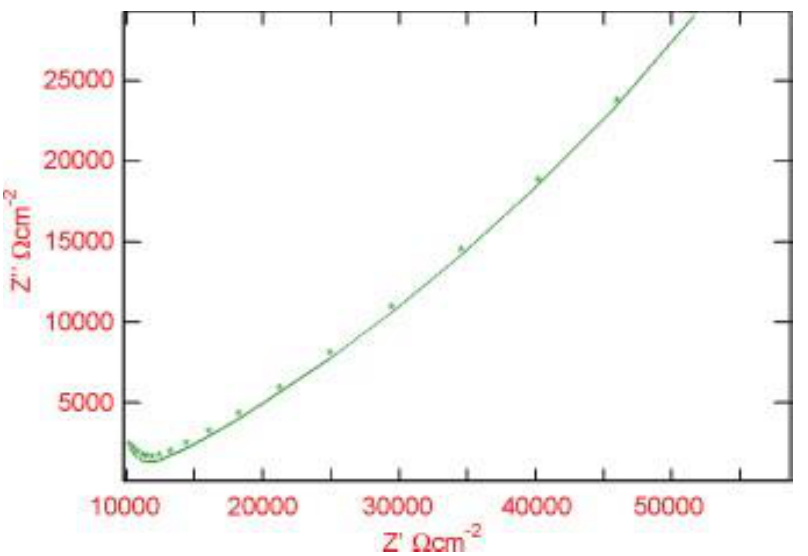
Figure 5. Impedance plot for MnO 2 sensor embedded in concrete with 0% Cl − and submerged in saturated calcium hydroxide solution. Reproduced with permission from ref. [94]. Copyright 2008 Elsevier. Table 4. Parameter of AC impedance for MnO 2 sensor embedded in concrete [94]. Reproduced with permission from ref. [94]. Copyright 2008 Elsevier.